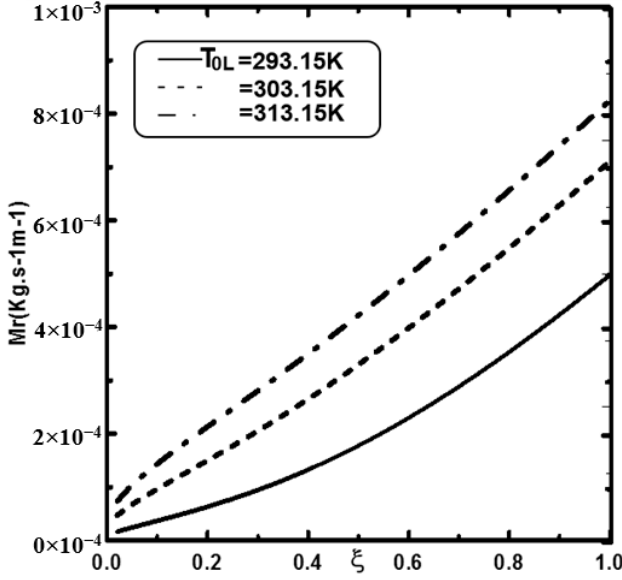
Figure 14. Evolution of the cumulated evaporation rate to various inlet liquid temperature: T 0 = 293.15 K, c 0 = 0, q 1 = 3000 W/m 2 , T w = 293.15 K, u 0 = 1 m/s, p 0 = 1 atm, m 0L = 15 × 10 − 4 Kg/m · s, H = 1 m, d = 0.015 m, ϕ 0 = 0.03.